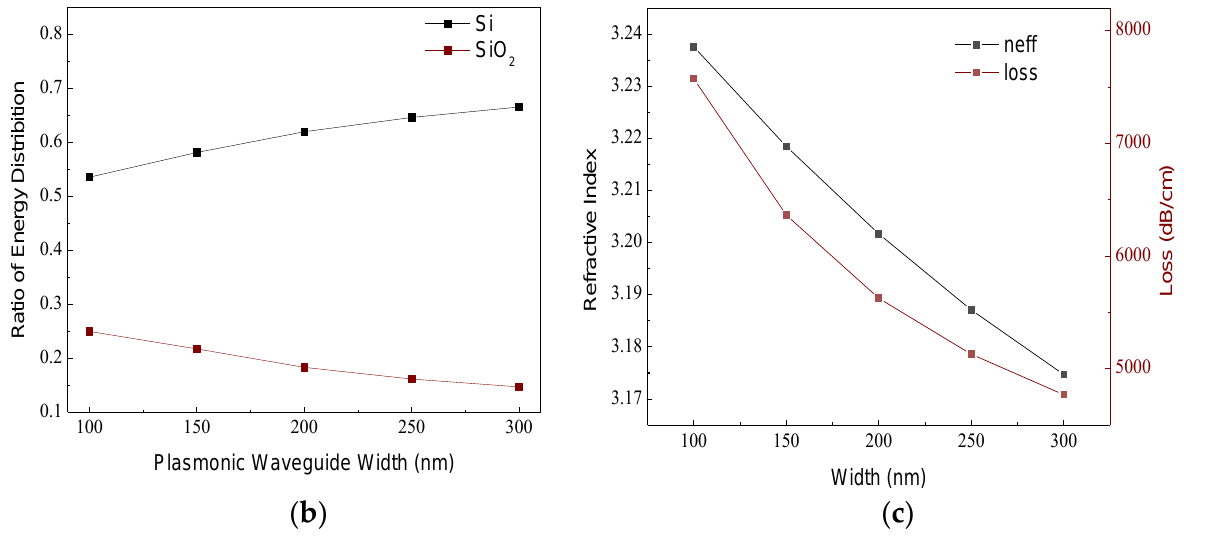
Figure 2. ( a ) The normalized electric field distribution in the plasmonic waveguide as the width varies from 100 nm to 300 nm; ( b ) the ratio of energy distribution in the plasmonic waveguide as the width varies from 100 nm to 300 nm; ( c ) the change in n eff and loss with varying plasmonic waveguide width.